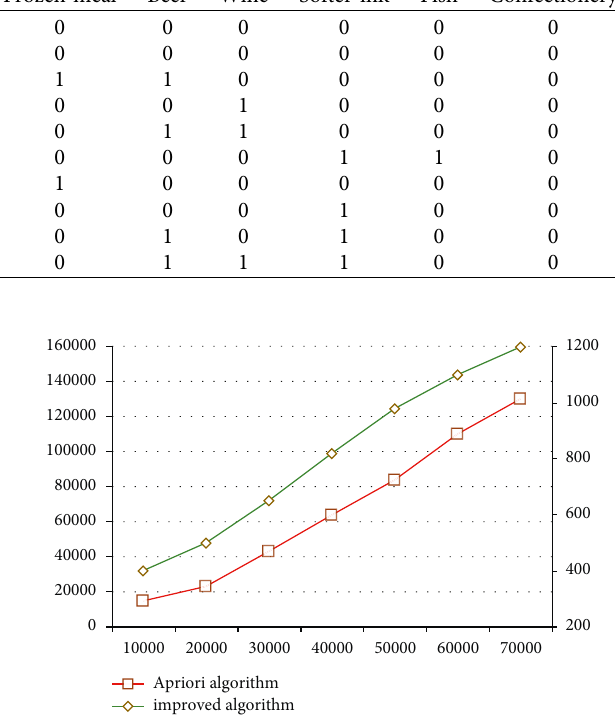
Figure 6: Comparison of the execution time of two algorithms with different numbers of